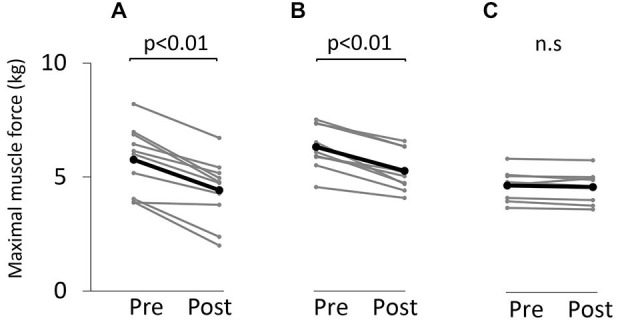
Maximum muscle force before and after the tasks. (A) VC task. (B) Tetanic ES task. (C) The 90% MT ES task. Gray bars indicate the raw waveform of each participant. Black bars indicate the average.